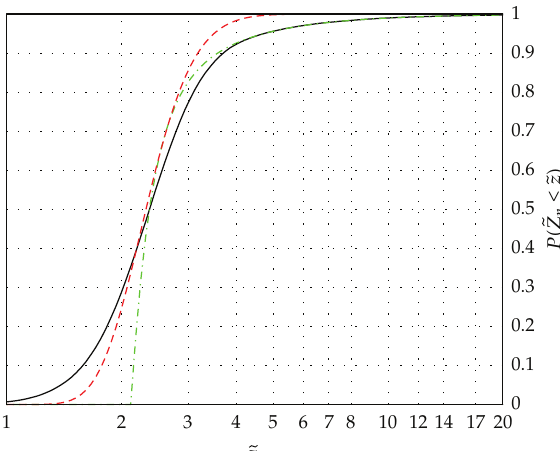
(cid:20) Figure 1: Plot of the probability pr (cid:2) Z n ≤ (cid:20) z (cid:3) for 1 ≤ (cid:20) z ≤ 20 with n (cid:4) 10 5 . The x -axis is plotted on a log scale. The black solid curve is computed from 10 6 Monte Carlo simulations. The red-dashed curve is based on (cid:2) 3.13 (cid:3) . The green dot-dashed curve is computed from (cid:2) 3.14 (cid:3)